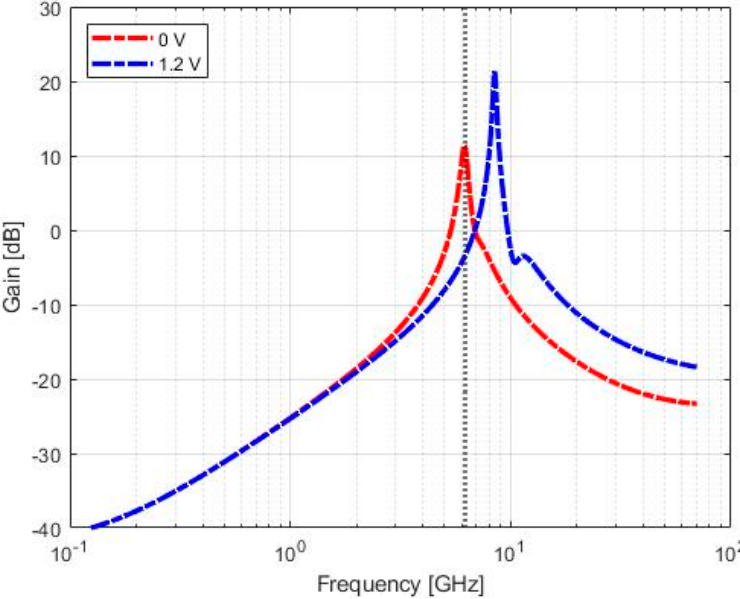
Figure 6. Frequency response simulated for minimum (red line) and maximum (blue line) values of the control voltage. The vertical marker indicates the target frequency of 6.25 GHz.